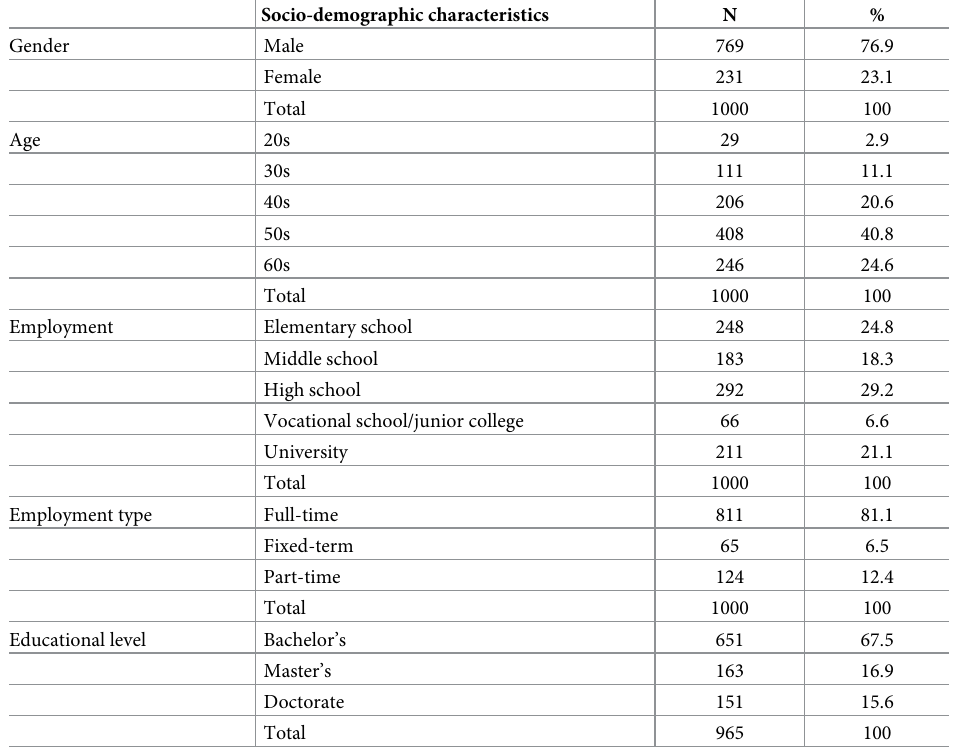
Table 1. Participants’ demographic